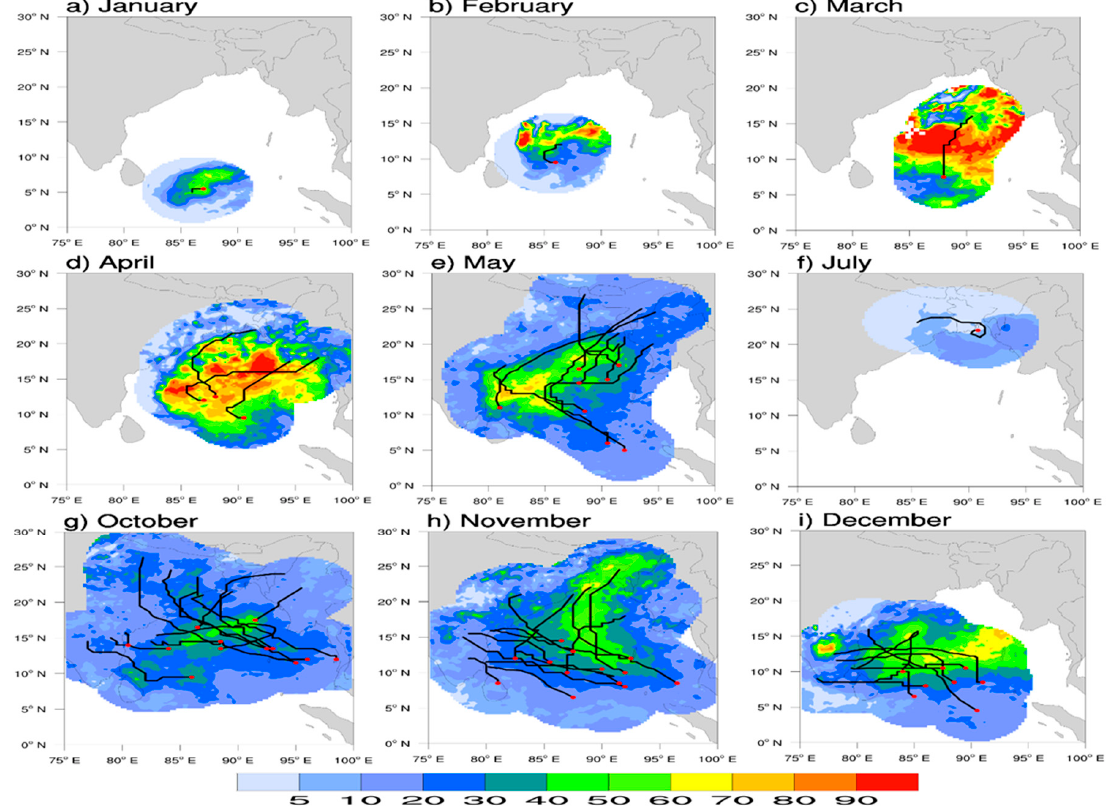
Figure 10. Monthly TC rainfall contribution (%) from January to December. The months June, August, and September were omitted because there was no TC activity in these months. The red circle indicates the genesis point of TCs. ( a ) January, ( b ) February, ( c ) March, ( d ) April, ( e ) May, ( f ) July, ( g ) October, ( h ) November, ( i ) December.